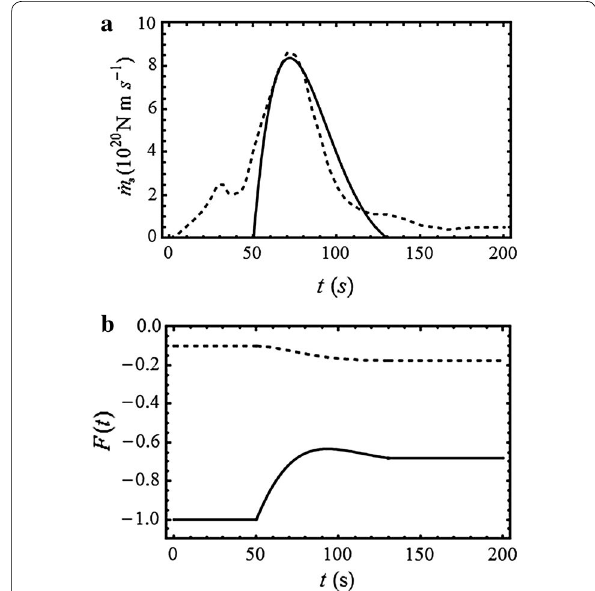
Fig. 8 Coseismic phase of the 2011 Tohoku-Oki earthquake. a m s (solid) as a function of time, calculated according to Moment rate ˙ (106), compared with the observed moment rate (dashed) reported by Wei et al. (2012). b Evolution of forces F 1 on the asperity (solid) and F 2 on the weak region (dashed), in units of the static friction f s of the asperity